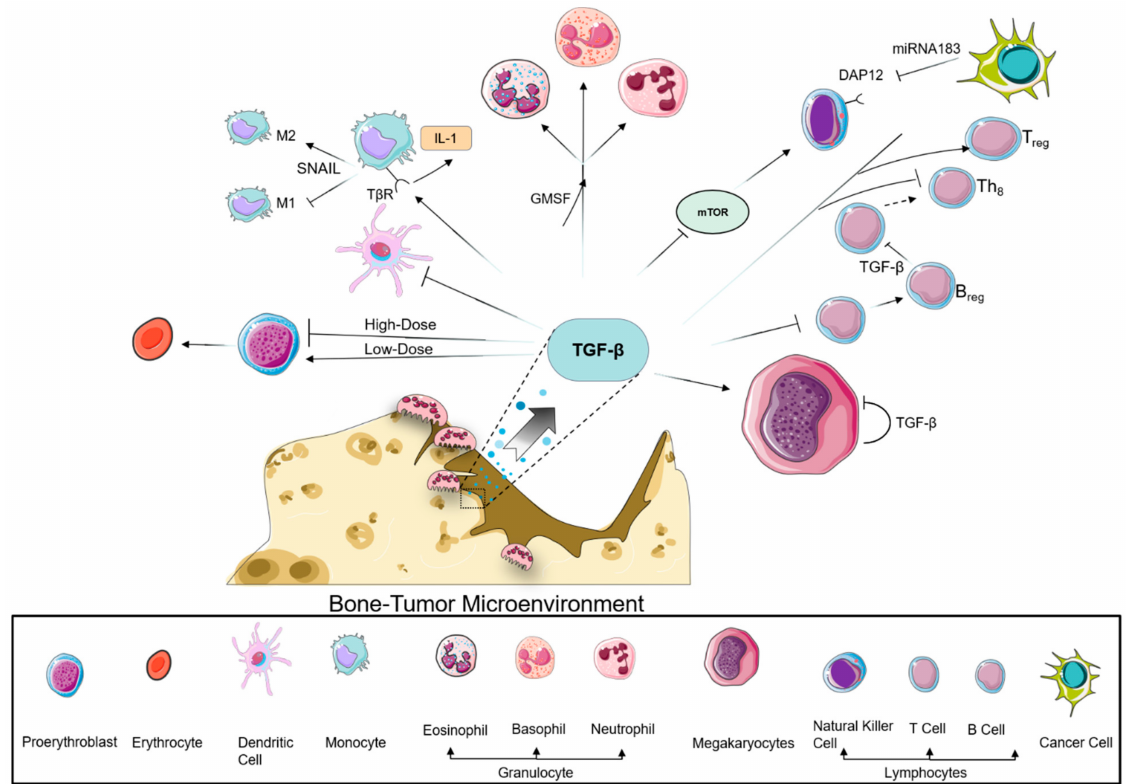
Figure 2. Role of TGF- β in immune cells of the marrow. Excess release of TGF- β from the bone matrix exerts a multitude of interactive effects on the surrounding immune cell populations within the bone marrow. Erythropoiesis is affected in a polarized fashion, where TGF- β induces red blood cell proliferation at low concentrations, while higher concentrations are inhibitory to proerythroblasts. TGF- β upregulates granulocyte differentiation and binds to its surface receptor on monocytes to drive M2 maturation via Snail while suppressing the M1 macrophage phenotype. Lymphoid maturation is blockaded through multiple pathways. Bone-derived TGF- β and autocrine synthesized TGF- β suppress the function and proliferation of megakaryocytes. Differentiation of immature lymphoblasts is suppressed, preventing proliferation of B and T cells but driving the T reg phenotype. Additionally, TGF- β inhibits mTOR, which is necessary in natural killer cell recognition of cancer